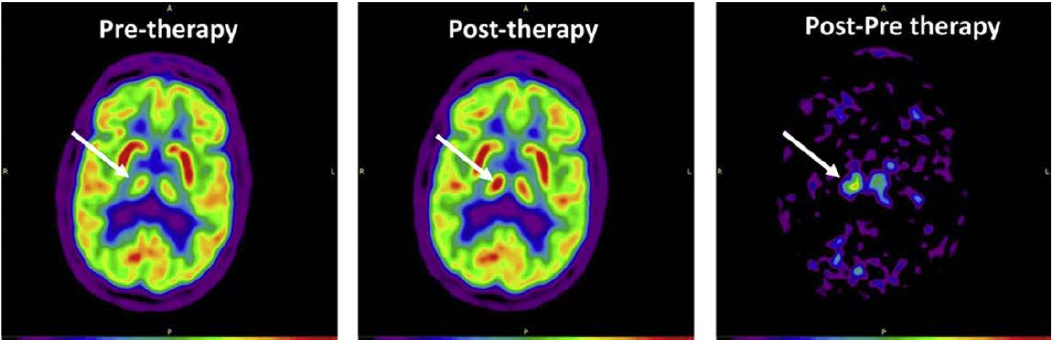
Figure 2. An example of FDG-PET image, taken from Rudroff et al. 2019 [25]. FDG-PET transaxial image acquired pre- and post-tDCS therapy. Images are scaled in standardized uptake values normalized to the global mean value (Max = 1.88 for pre-and post-therapy and 0.5 for post-pre therapy). The white arrow indicates the right thalamus, the area with the greatest difference between the images. The color bar describes increasing FDG uptake with increasing signal intensity (from black, indicating no glucose uptake, to red, indicating the greatest glucose uptake).